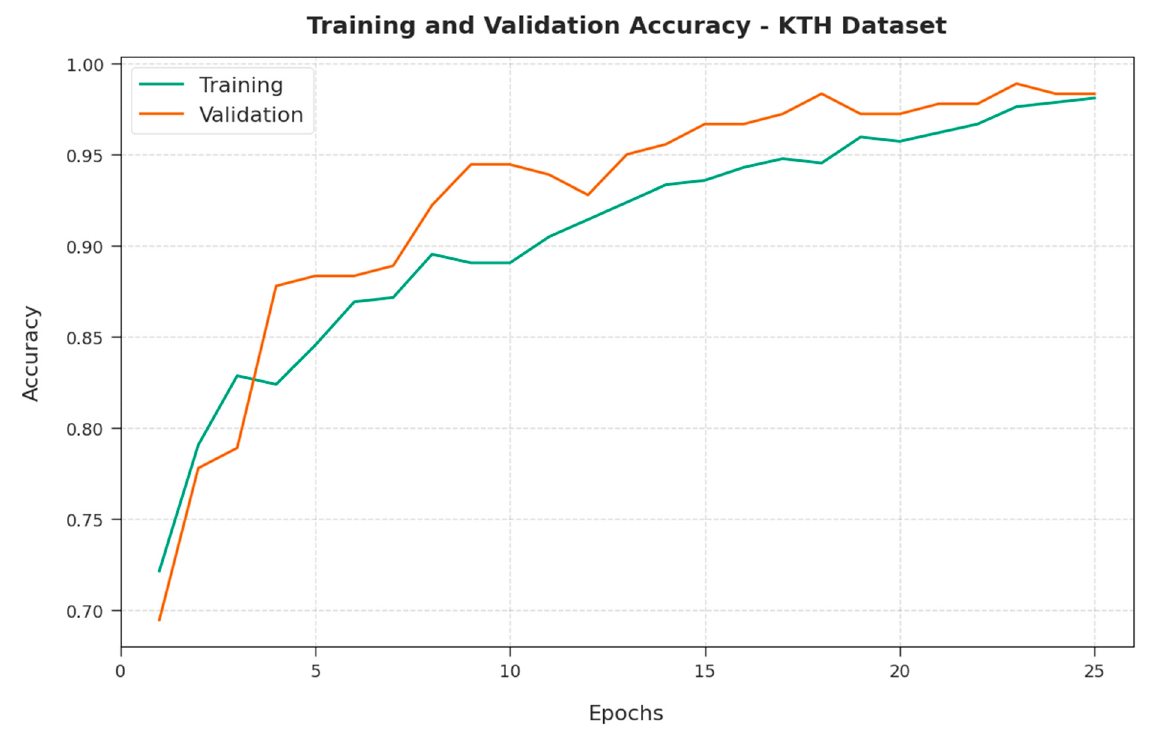
Figure 4. Training and validation accuracies of QWSA-HDLAR model on KTH dataset.